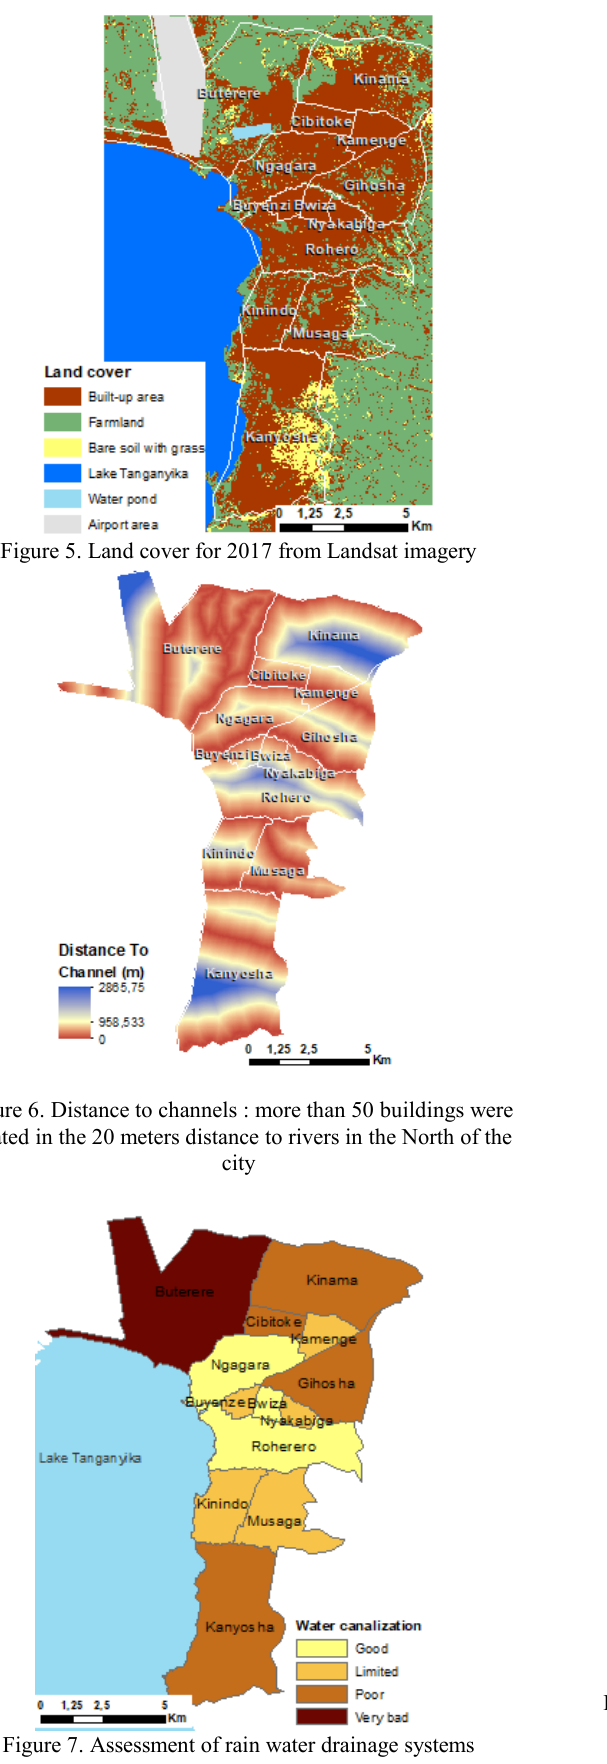
Figure 7. Assessment of rain water drainage systems